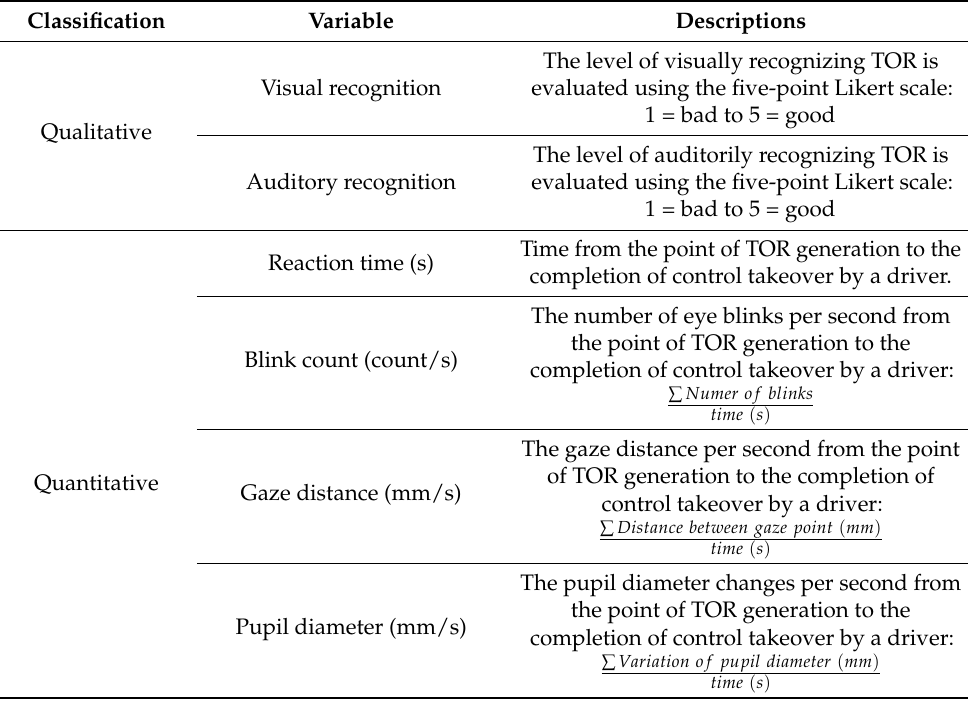
Table 3. Summary of the dependent